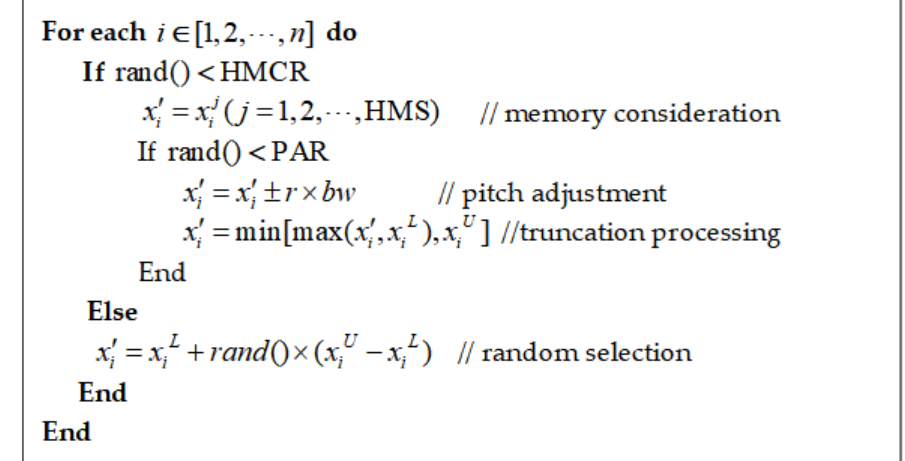
Figure 1. Generating a new harmony by classical HS algorithm.